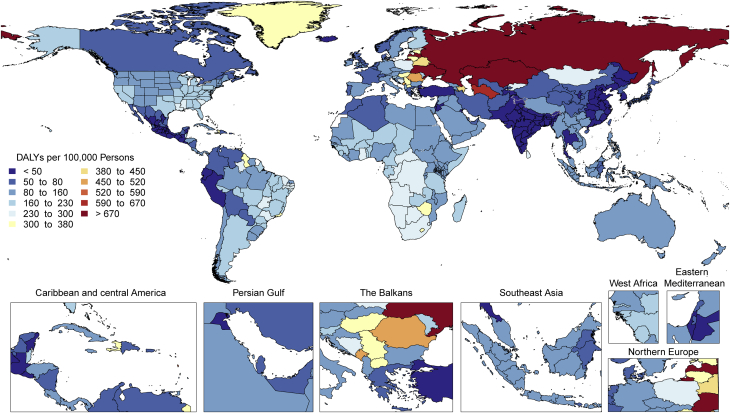
Map of Age-Standardized DALYs Due to Cardiomyopathy and Myocarditis in 2019DALYs = disability-adjusted life years.